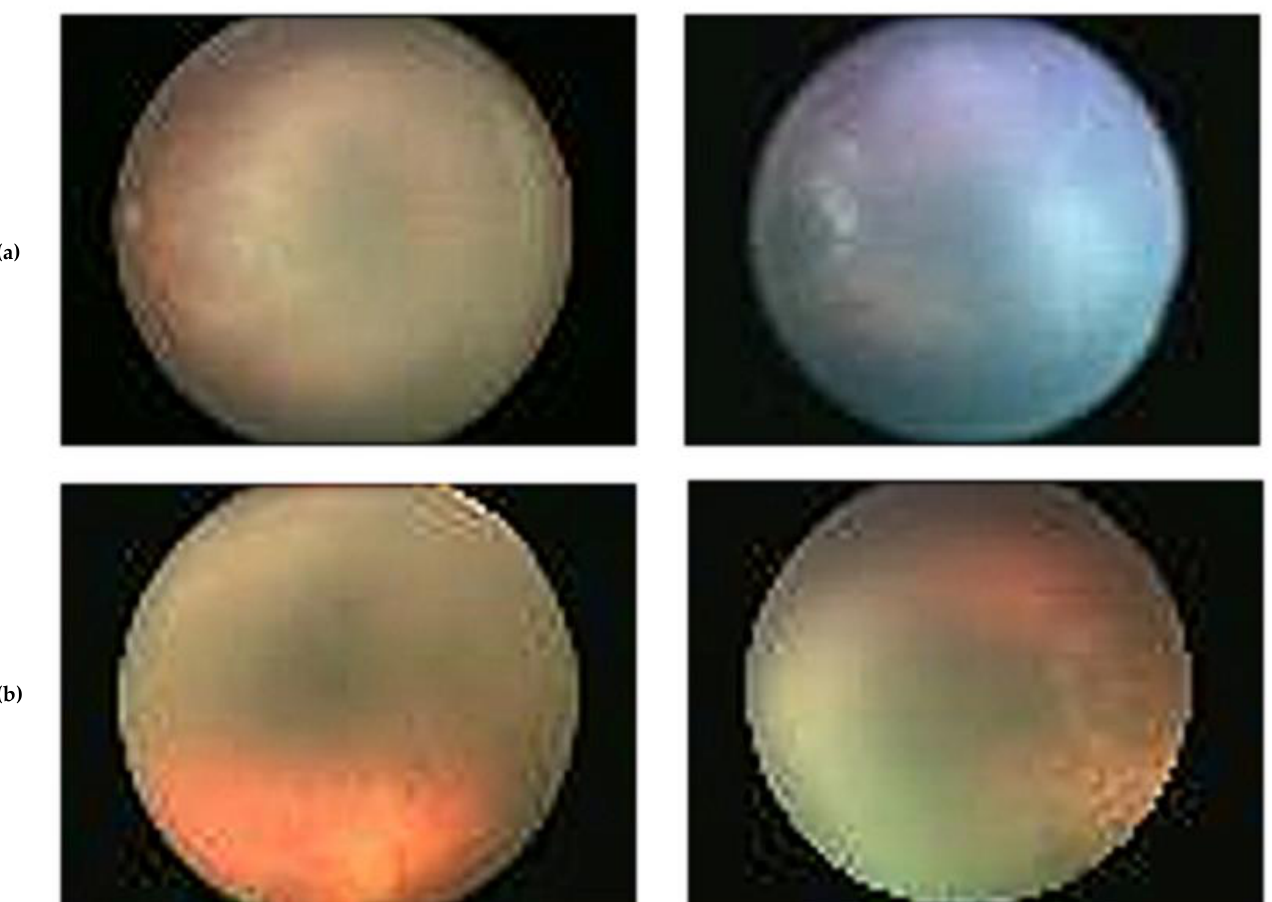
Figure 1. Examples of the dataset’s images, ( a ) diseased and ( b ), not diseased.